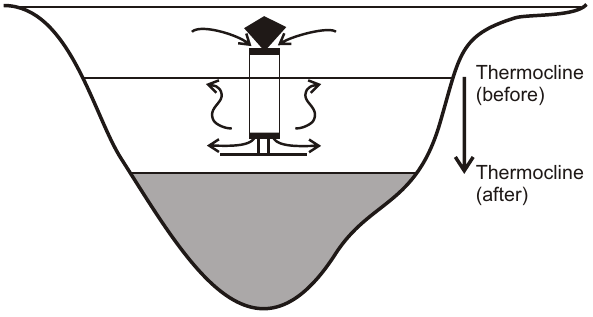
Fig. 2. The experimental design in lake Halsj¨arvi using the modified aeration